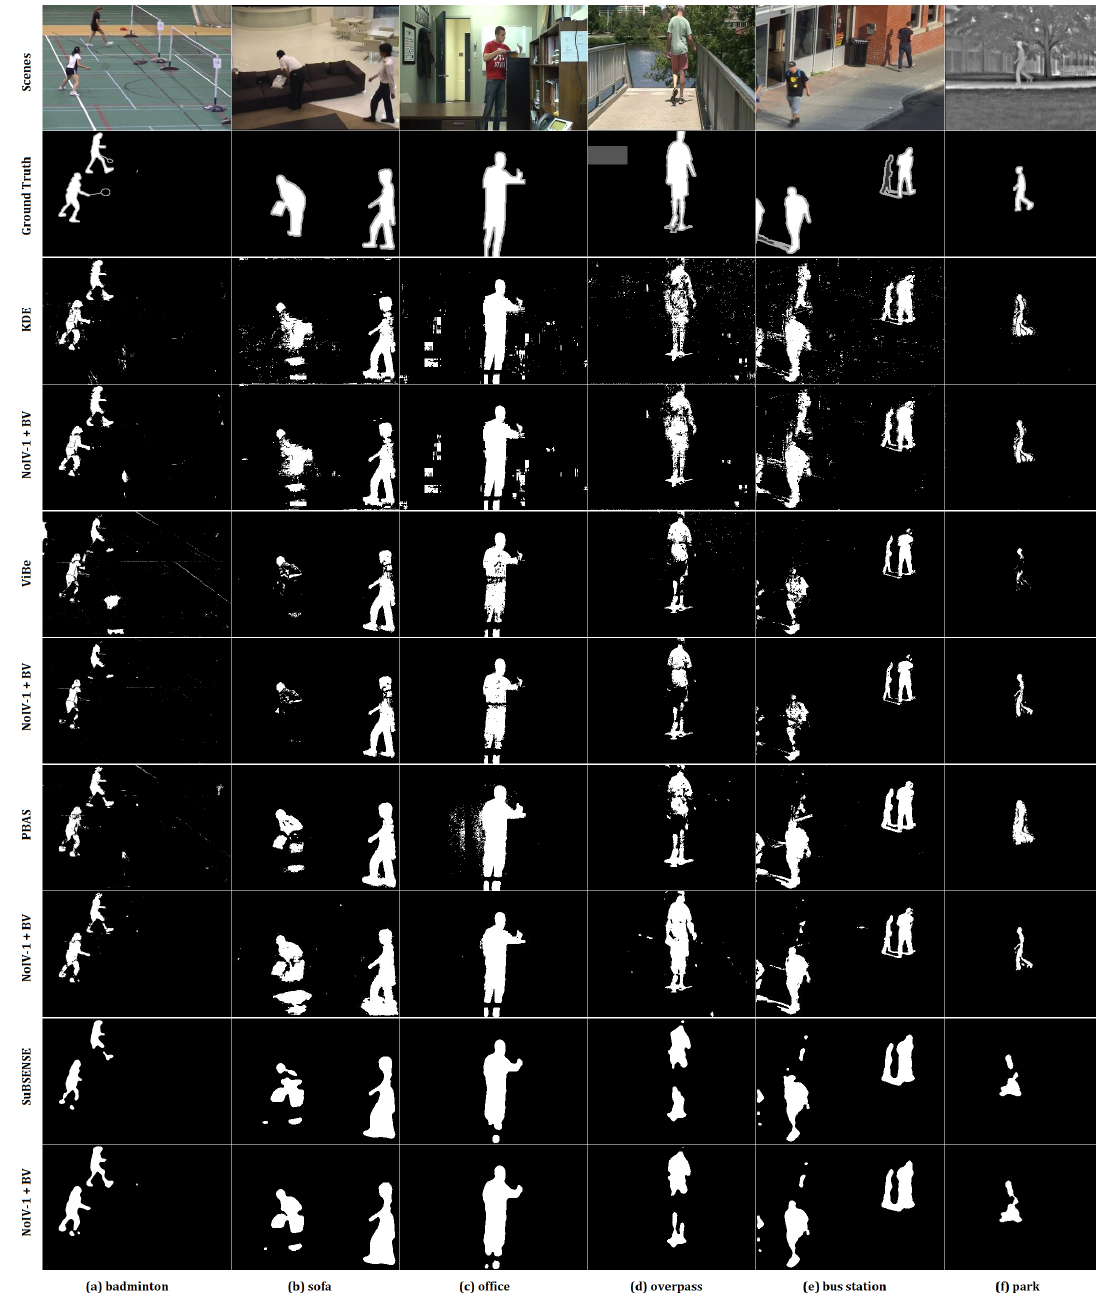
Figure 10. Scenes from column ( a – f ) are from categories camerJitter , intermittentObjectMotion , baseline , dynamicBackground , shadow , and thermal ,